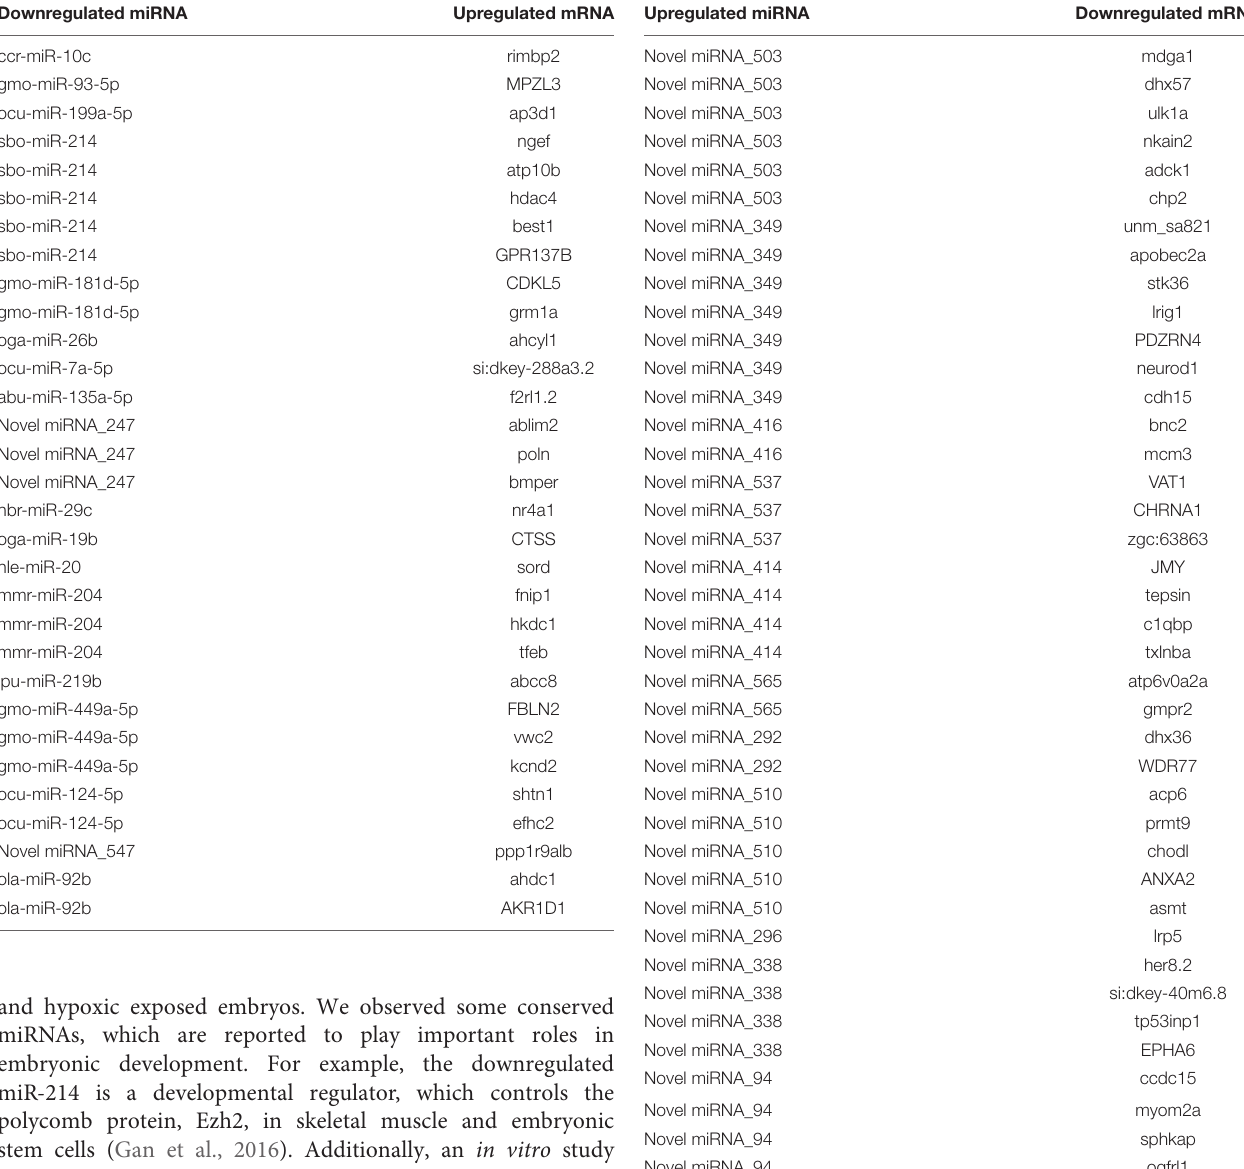
TABLE 5 | Hypoxia-induced upregulated miRNA-downregulated mRNA pairs in medaka